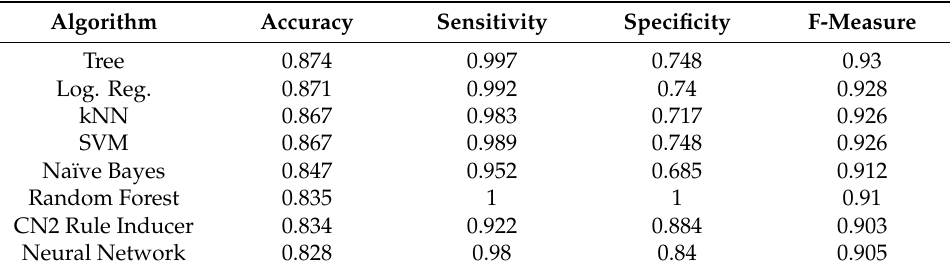
Table 9. Feature selection using genetic algorithm and